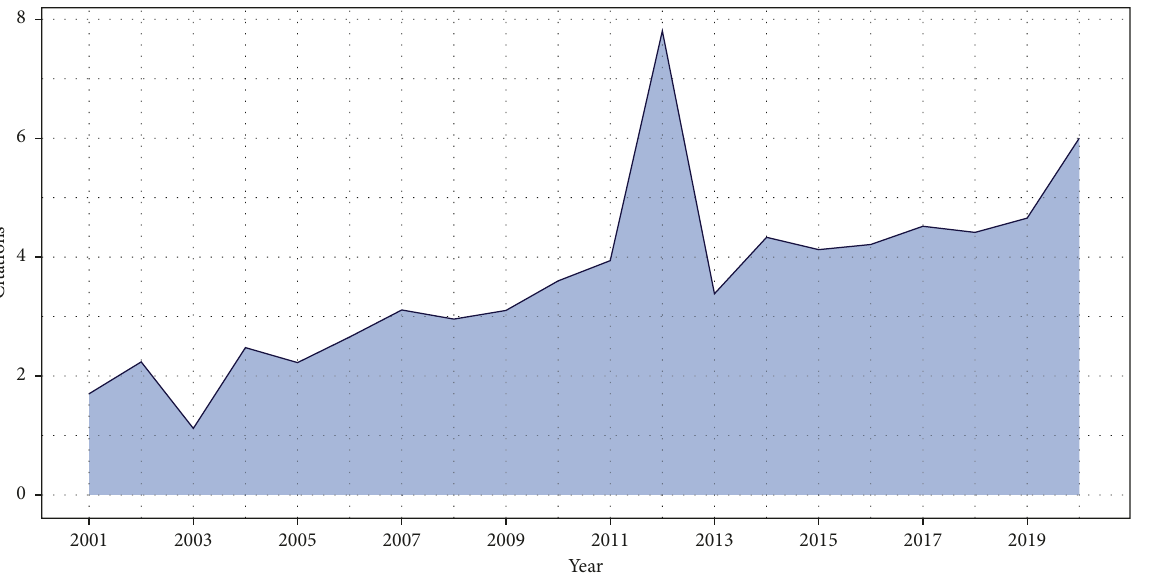
Figure 3: Average annual citations in computational social science,